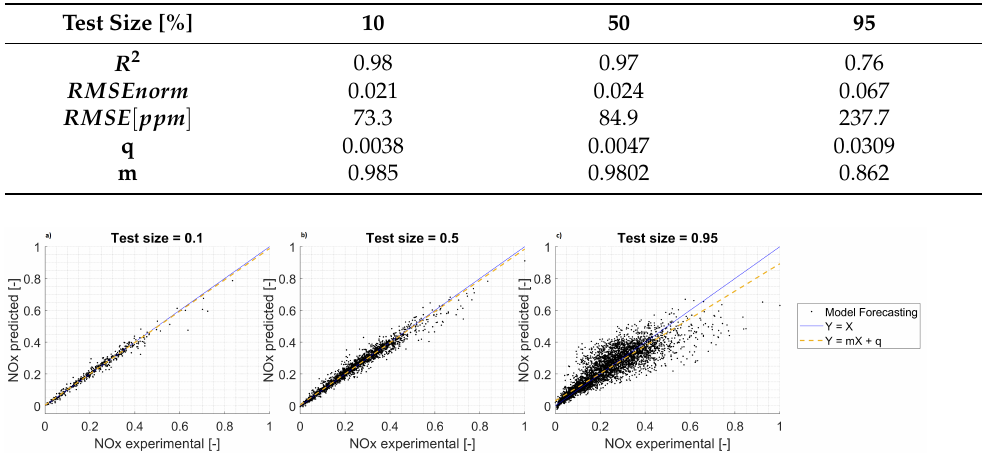
Figure 5. Regression prediction results test dataset for ECU test conditions. Sensitivity analysis on the three different size of test dataset: ( a ) 10%, ( b ) 50% and ( c ) 95%.